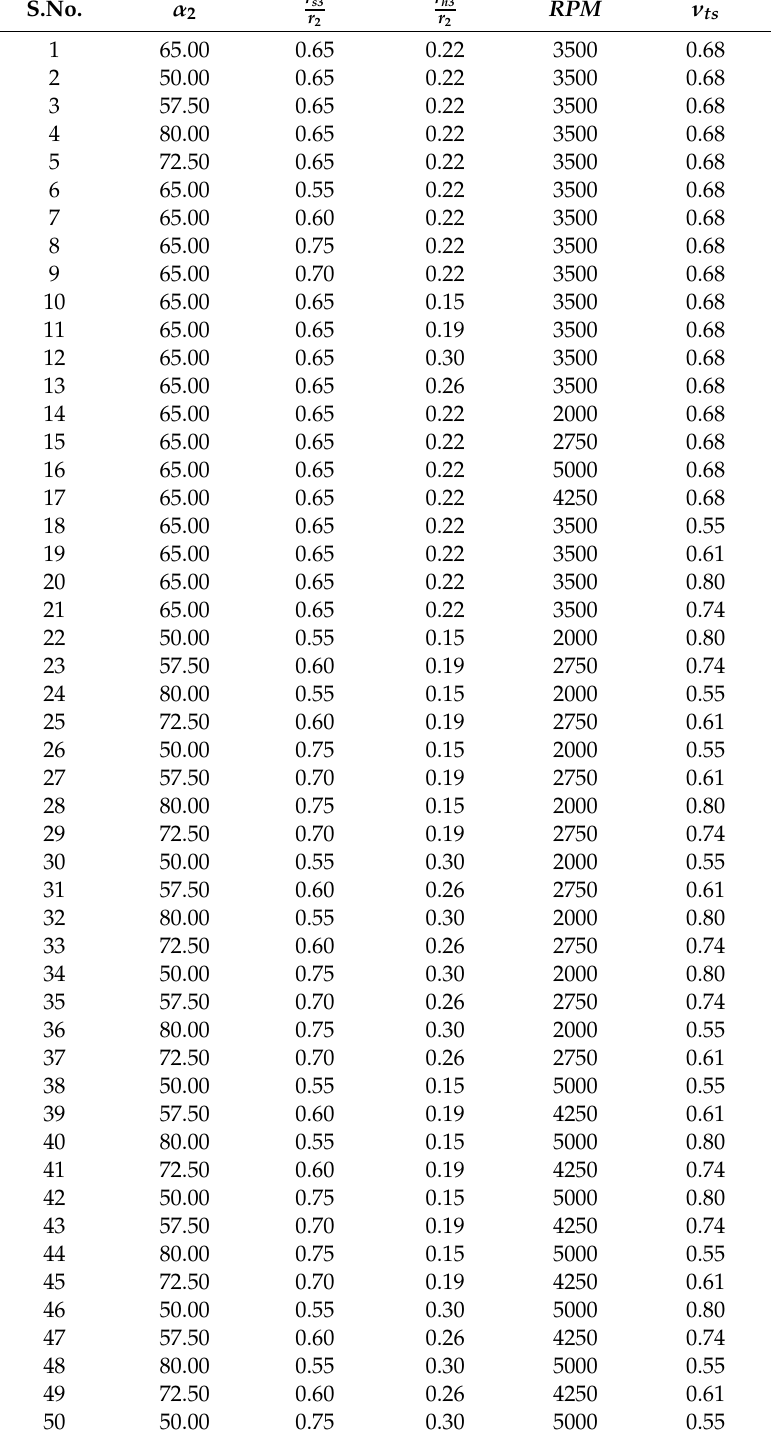
Table 3 was computed using the meanline turbine design code (Figure 5). Now computed power of the turbine as a response variable f(x) for all designs listed in Table 3 can be used to solve the Equation (26) through regression analysis. Table 3. Design of experiment using Central Composite Design